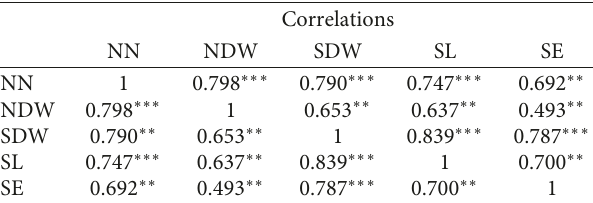
Table 3: Pearson correlation coefficient comparisons for nodule number, nodule dry weight, shoot dry weight, shoot length, and symbiotic effectiveness.